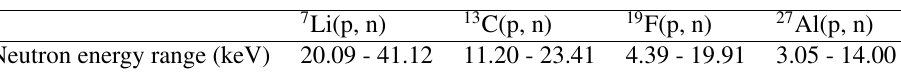
Table 1. Emitting neutron energy range at threshold energies for di ff erent reactions.